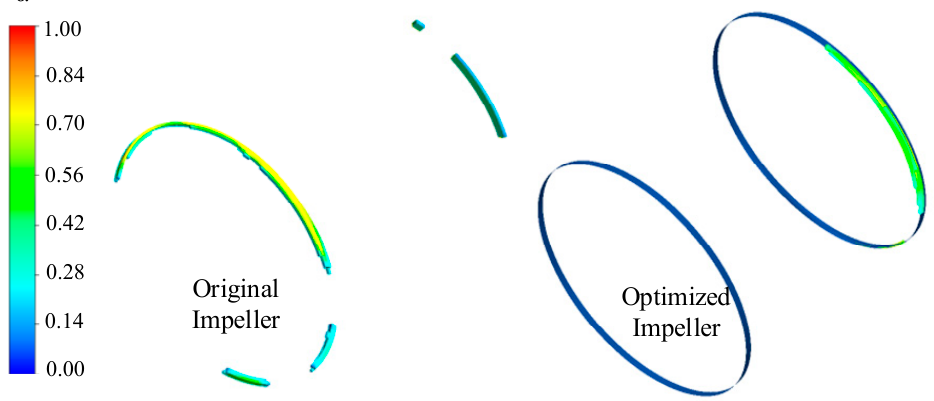
Figure 22. Volume fraction distribution in impeller at critical cavitation.